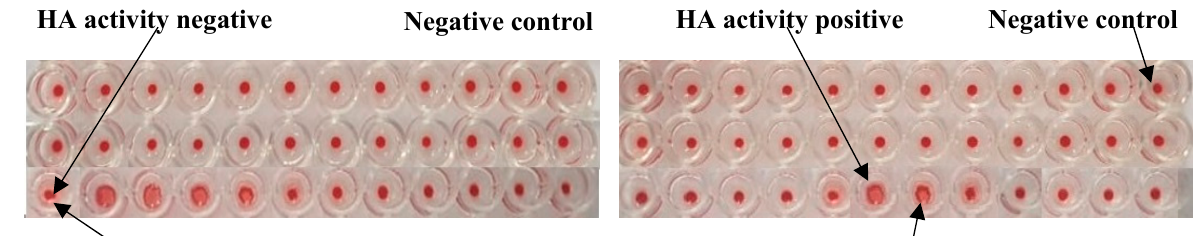
Figure 3. HA activity of AIV/H9N2 after mixing the Au-20 and Au-PVP-20 formulation for a 20-min microplasma discharge time. ( a ) HA activity of Au-20; ( b ) HA activity of Au-PVP-20.